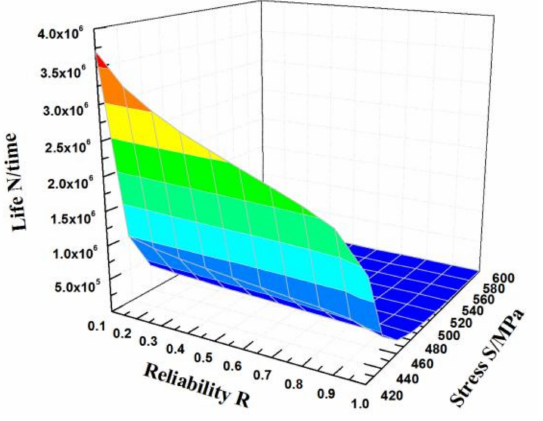
Figure 10. Variation in the fatigue life of HL-type sucker rod as a function of stress and